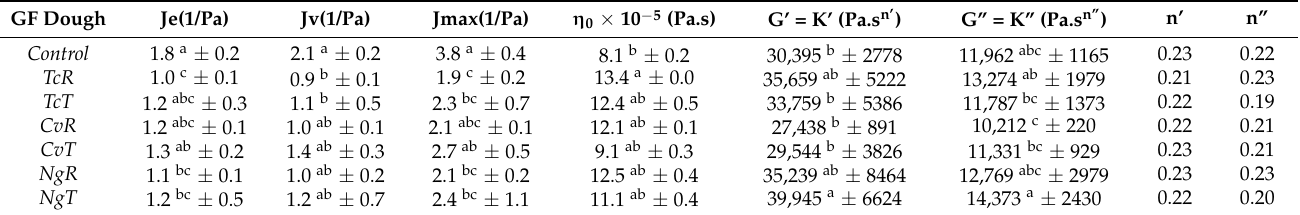
Figure 2. Representative creep and recovery curves ( A ) and mechanical spectra ( B ) of the control dough and those with a 4% replacement of Tetraselmis chuii (TcR), Tetraselmis chuii ethanol-treated (TcT), Chlorella vulgaris (CvR), Chlorella vulgaris ethanol-treated (CvT), Nannochloropsis gaditana (NgR), and Nannochloropsis gaditana ethanol-treated (NgT). Table 3. Elastic recovery compliance (Je), viscous recovery compliance (Jv), maximum creep com- pliance (J max ), zero shear viscosity ( η 0 ), and parameters from frequency sweep expressed from the power-law model: storage moduli (G’) and flow index (n’), loss moduli (G”), and flow index (n”) of doughs prepared with the control dough and those with 4% replacement of different microal- gae